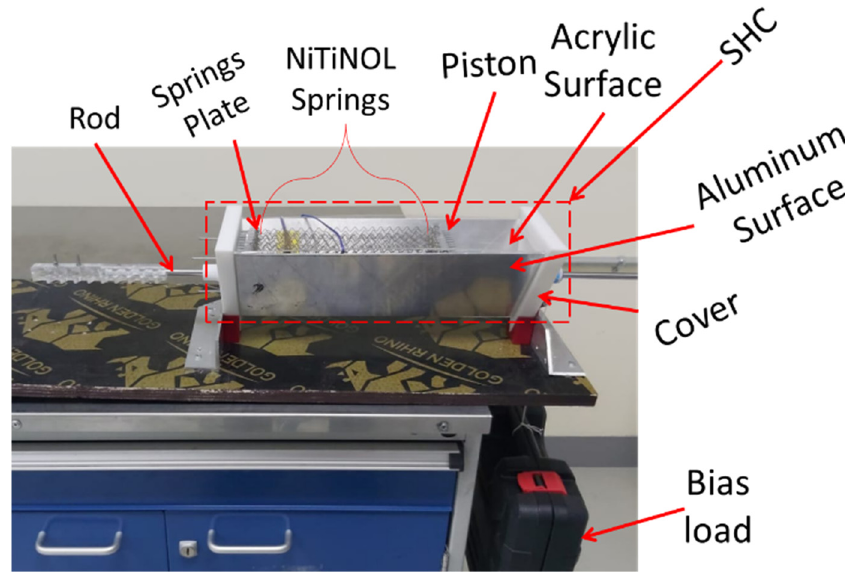
Figure 4. The actual model of the solar-driven thermomechanical SMA actuator.